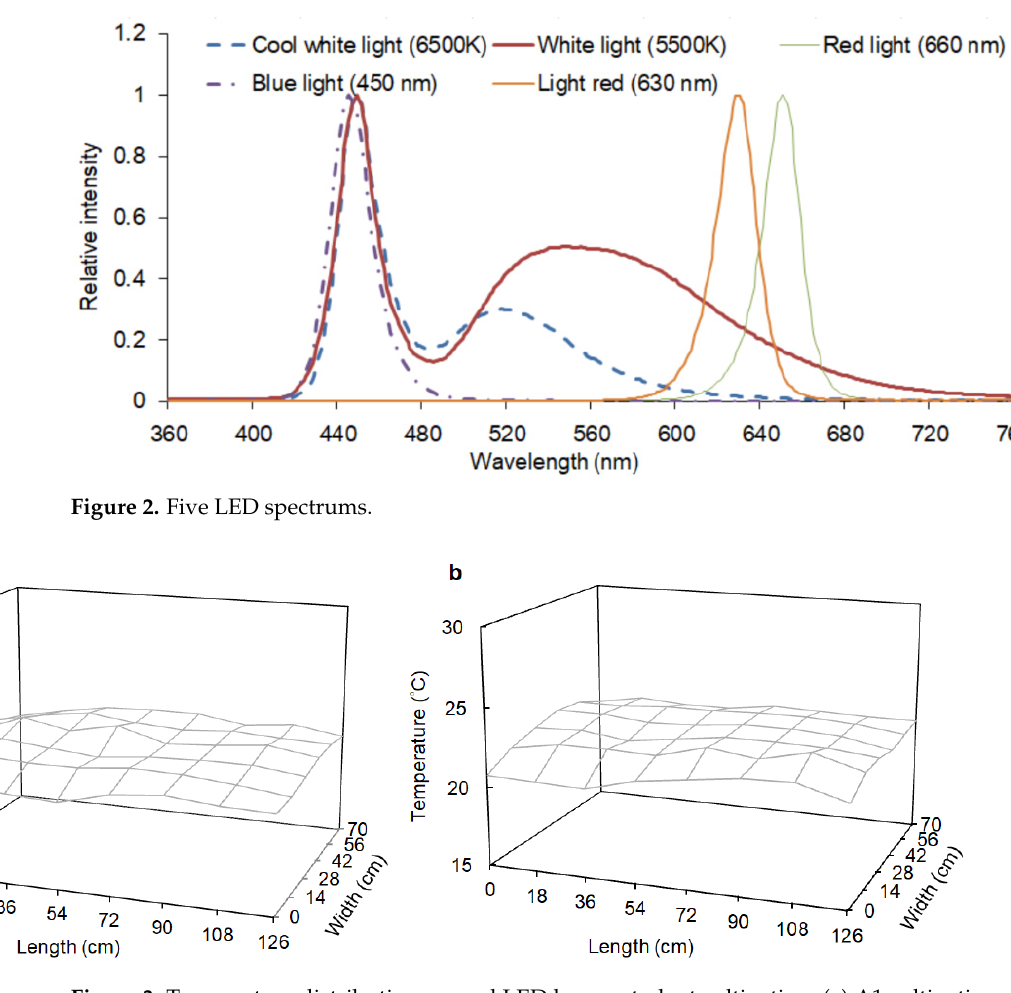
Figure 3. Temperature distribution around LED lamps at plant cultivation. ( a ) A1 cultivation zone, ( b ) B1 cultivation zone. The ambient temperature is 20 ± 2 °C. In addition, circulation fans placed on the right side and above the left side of each planting area (Figure 4) were used for air circulation and to reduce the heat concentration around the LED